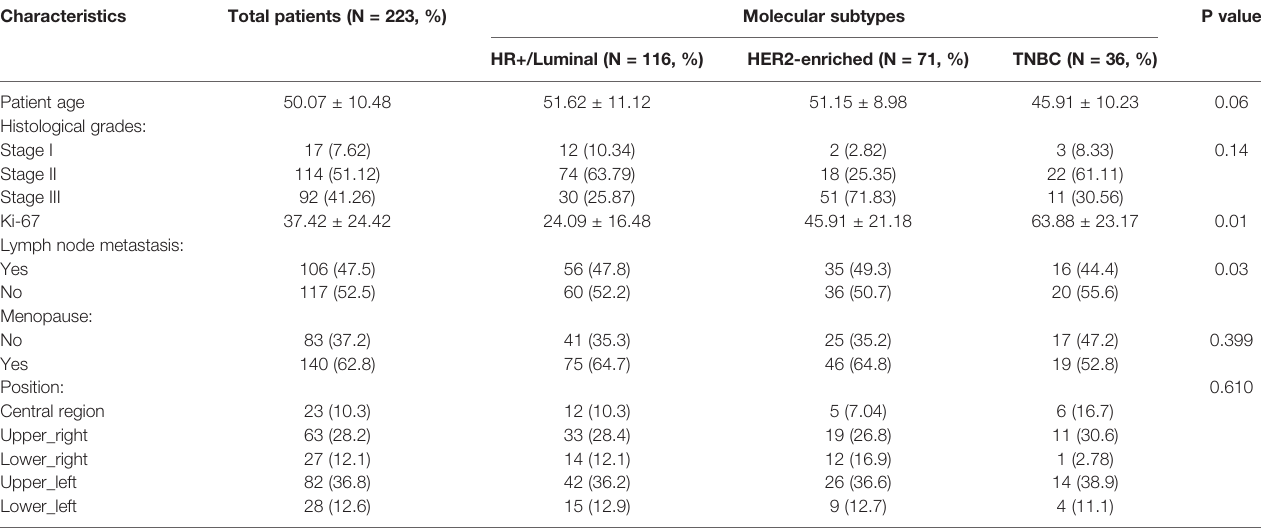
TABLE 1 | Clinical and histopathologic characteristics of patients grouped by molecular subtypes.